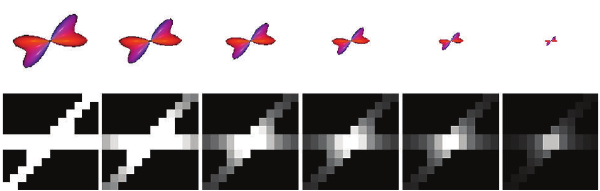
Figure 3: Gray value scaling of cylinders depending on the FOD